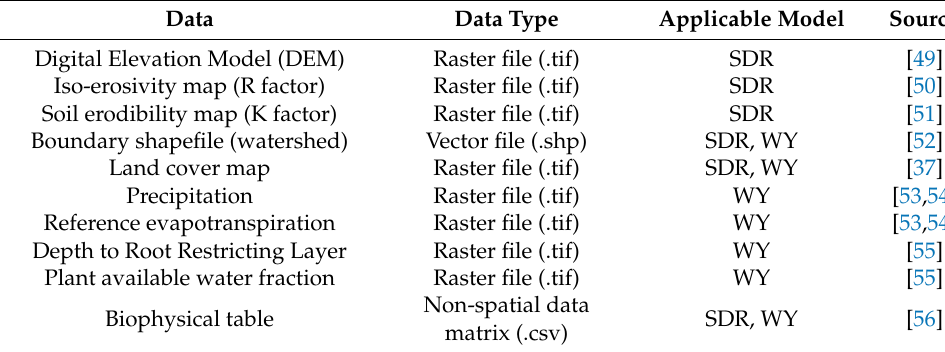
Table 1. List of required data inputs for the InVEST models. Data